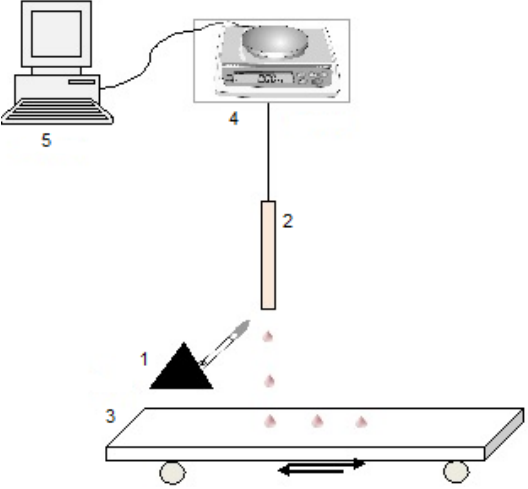
Figure 3. A schematic sketch of the experimental set ‐ up equivalent to the UL ‐ 94 test: 1—burner; 2—tested polymer sample; 3—conveyer belt with aluminium foil; 4—analytical balance; 5—computer (used by Kandola et al. [7]).